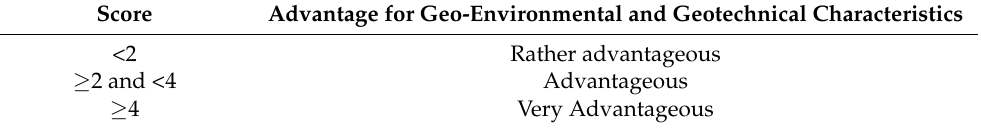
Table 2. Suitability on geo-environmental and geotechnical